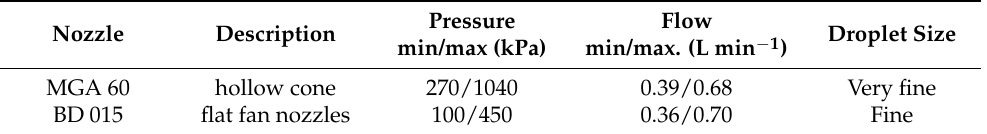
Table 5. Specification of the spray nozzles used.